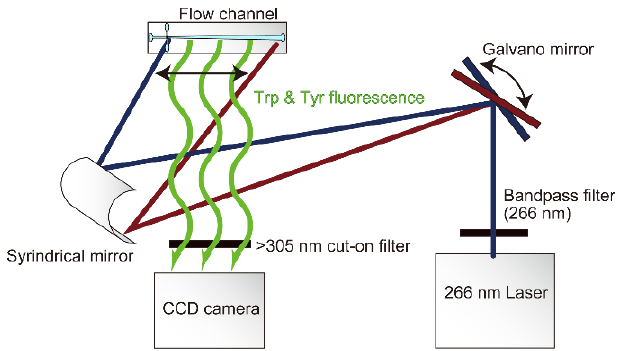
Figure 2. Optical configuration of our new continuous-flow instrument, using a UV laser in conjunc- tion with a pair of Galvano mirrors to achieve uniform fluorescence excitation along the flow channel of the microfluidic mixing chip (Figure 1B,C).